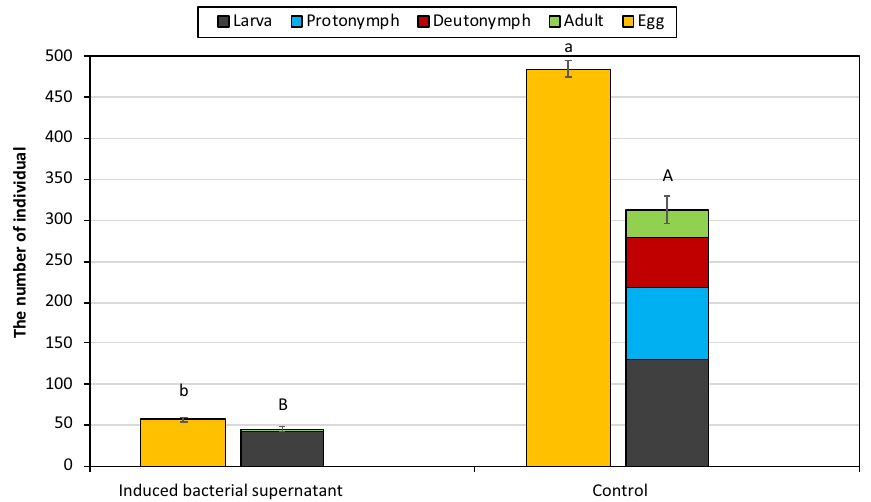
Figure 4. The effects of cell free supernatant produced by induced Xenorhabdus nematophila (pCEP_kan_ XNC1_1711) mutant strain on different biological stages of Tetranychus urticae in pot experiments.